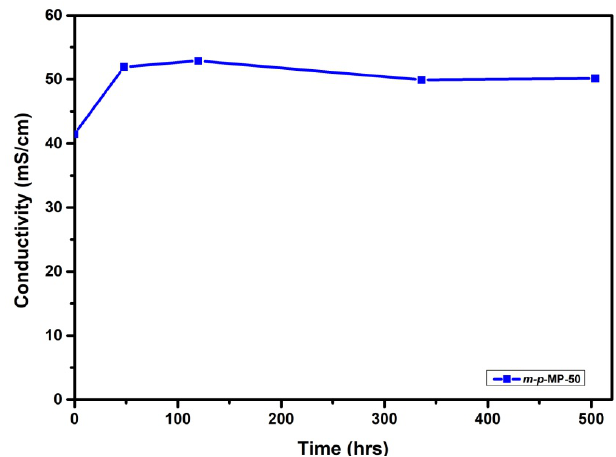
Figure 9. The alkaline resistance of the AEM sample m-p -MP-50 in 1M KOH at 80